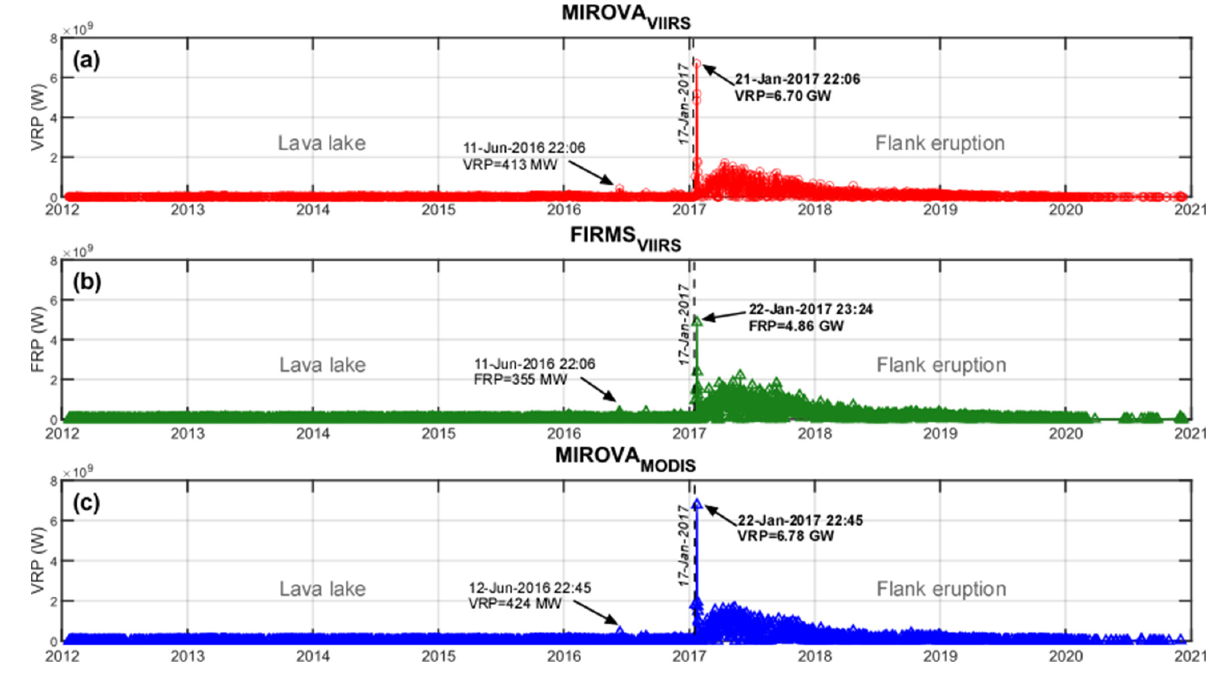
Figure 7. Time series of Erta Ale volcano. The panels show VRP calculated respectively from ( a ) MIROVA VIIRS (red circles), ( b ) FIRMS VIIRS (green triangles), and ( c ) MIROVA MODIS (blue triangles). For both MIROVA and FIRMS, the peak in VRP and FRP reported on the time series with bold characters occurs after the onset of the flank eruption. The left dates on the time series correspond to the overflow that occurred in June 2016. Black dashed lines separate the two phases of Erta Ale’s activity.